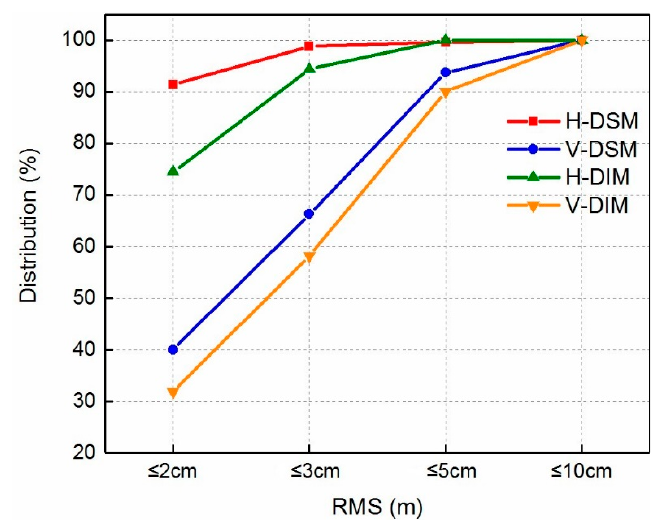
Figure 7. Distribution of RMS values in horizontal and vertical directions.